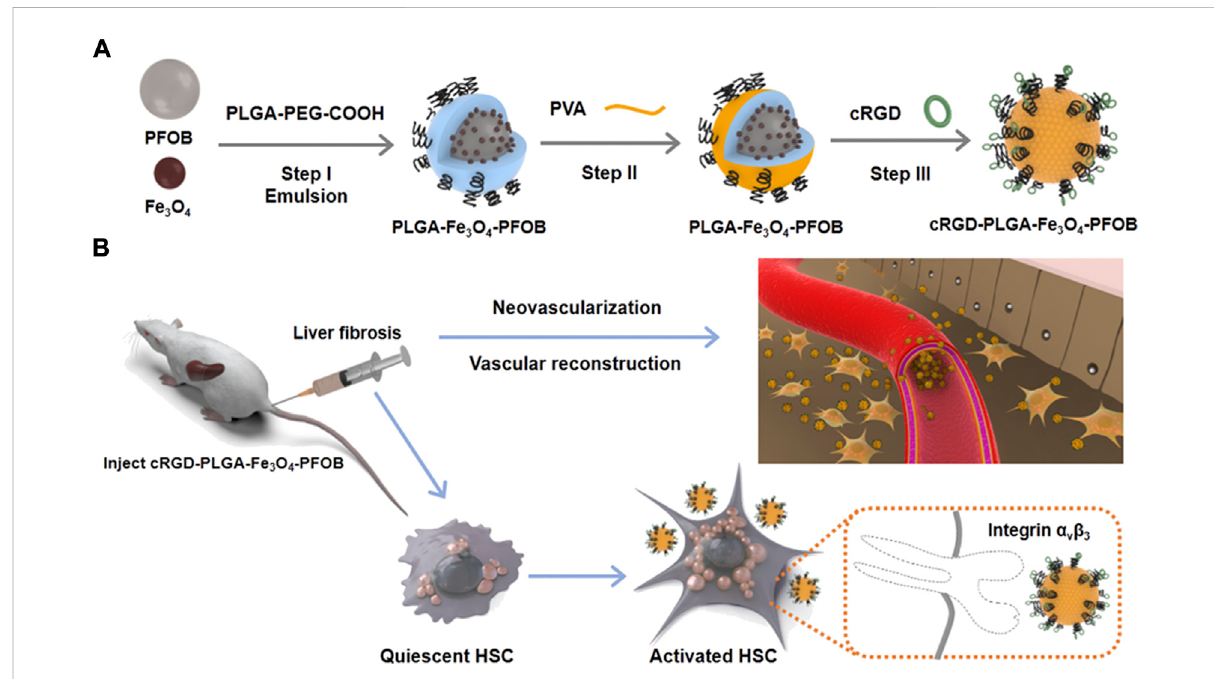
FIGURE 1 Schematic illustration of fabrication process of (A) cRGD-PLGA-Fe 3 O 4 -PFOB NPs and (B) their targeting capabilities to integrin α v β 3 expressed by